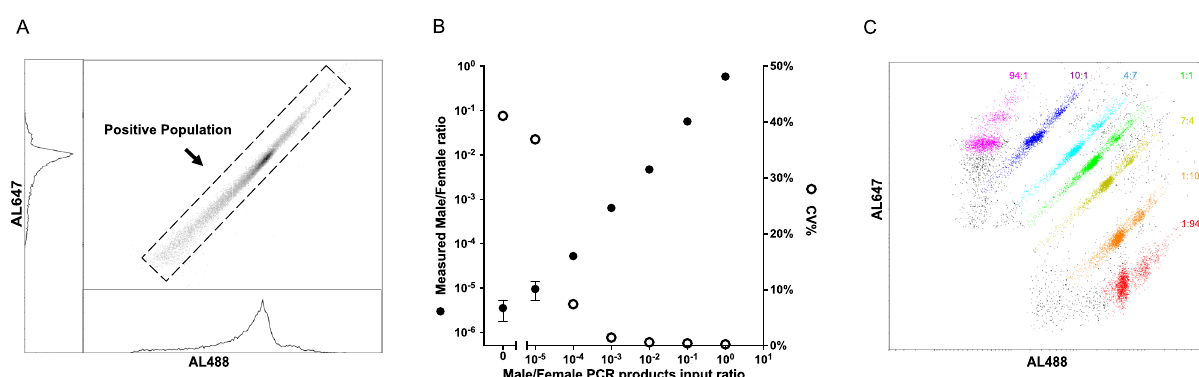
Fig. 3 Analysis of superRCA products via fl ow cytometry. A Flow cytometric analysis of superRCA products visualized using two hybridization probes, one labeled with the fl uorophore AL488 and one with AL647. B Flow cytometric analysis of superRCA products resulting from detection of a target sequence from the Y-chromosomal SRY gene compared to superRCA products for a sequence from the autosomal β -globin gene. Filled circles (·) identify the recorded proportions of superRCA products for the indicated input ratios of the two gene sequences. Open circles (o) denote the coef fi cients of variation (CVs) of triplicate measurements. Y chromosome-speci fi c superRCA products were still detected above background at a dilution of one in 100,000. n = 3 biological replicates were analyzed for this data set and the data are presented as mean value ± SD. C The large numbers of repeated sequences per superRCA product allows individual objects to be stained with combinations of two fl uorescence-labeled hybridization probes, as illustrated by plotting in false colors results for superRCA products stained using the indicated proportions of two oligonucleotides labeled with AL488 or AL647 and then pooled for fl ow cytometry